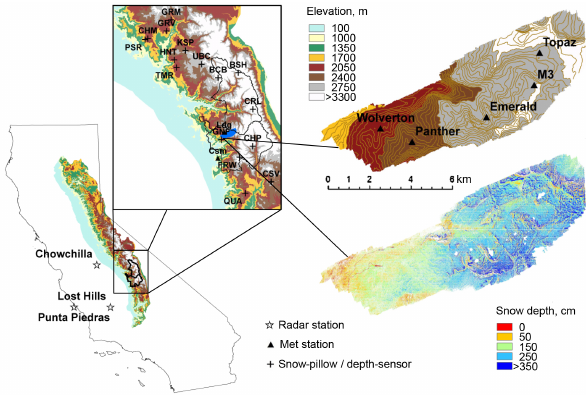
Figure 1. Study area and instrument locations. (Left) California with Sierra Nevada, outline of Sequoia and Kings Canyon Na- tional Parks, and location of radar stations. (Center) Location of snow sensors, and meteorological stations from north to south: Graveyard Meadow (GRV), Green Mountain (GRM), Chilkoot Meadow (CHM), Poison Ridge (PSR), Kaiser Pass (KSP), Hunt- ington Lake (HNT), Upper Burnt Corral (UBC), Tamarack Sum- mit (TMR), Bishop Pass (BSH), Black Cap Basin (BCB), Charlotte Lake (CRL), Lodgepole met (Ldg), Giant Forest (GNF), Chagoopa Plateau (CHP), Farewell Gap (FRW), Case Mountain met (Csm), Casa Vieja (CSV), and Quaking Aspen (QUA). (Upper right) El- evation and 50m contour map with locations of meteorological stations in LiDAR footprint. (Bottom right) LiDAR-measured 1m snow depth in areas free of vegetation.